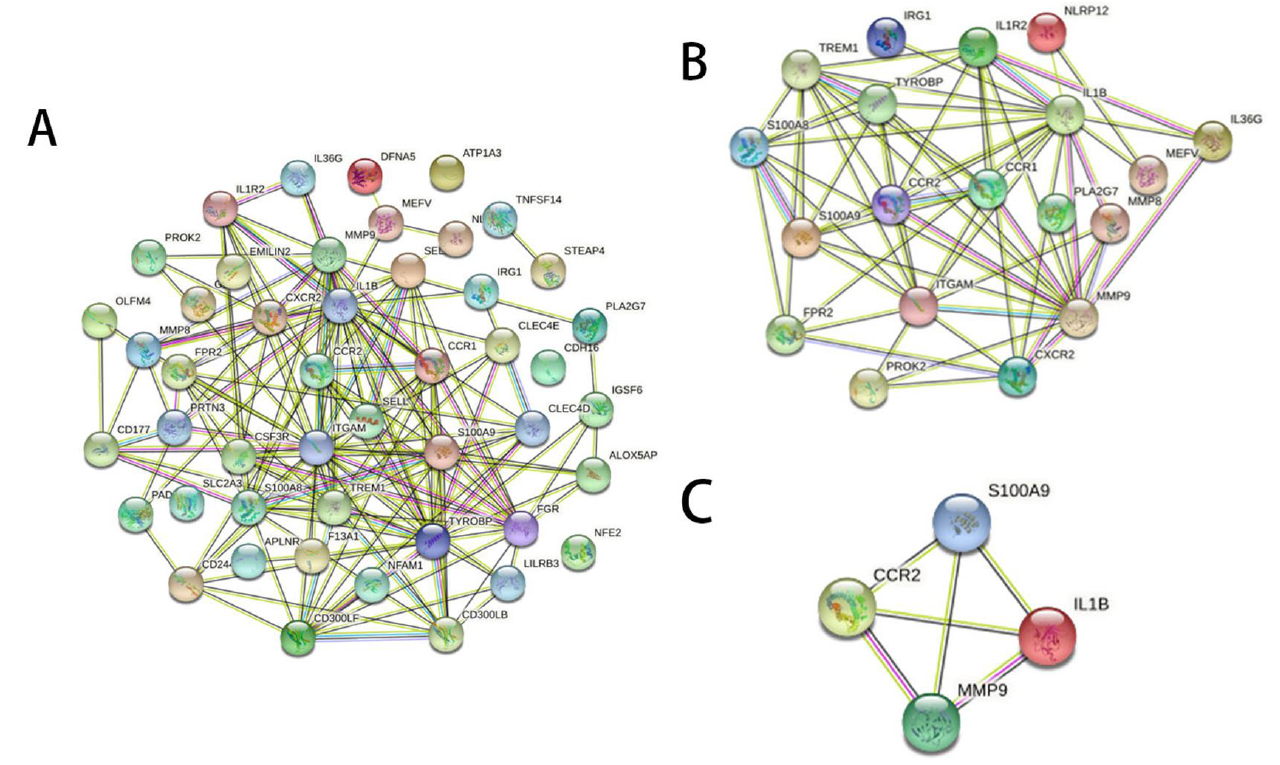
Figure 3. Gene interaction networks of DEGs. ( A ) PPI network of 47 DEGs which were homologous to the human counterparts. Nodes represent genes, edges represent interactions, and images inside each node represent the three-dimensional structure of each protein. ( B ) PPI network of the 19 inflammation-related DEGs. ( C ) PPI network of the four hub genes with the highest scores calculated by CytoHubba. Table 2. Results of KEGG signaling pathway analyses.